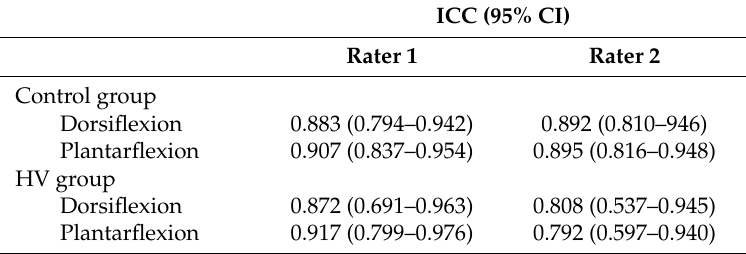
Table 3. Intrarater reliability (ICC) from day 1and 2 (separated by a minimum of 10 and a maximum of 30 days) for each first ray movement measured with the new device.